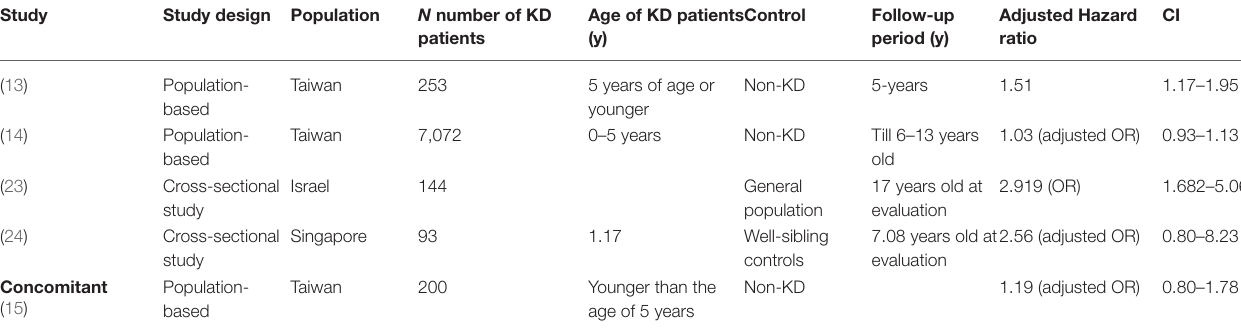
TABLE 1 | Effect of Kawasaki disease on asthma.